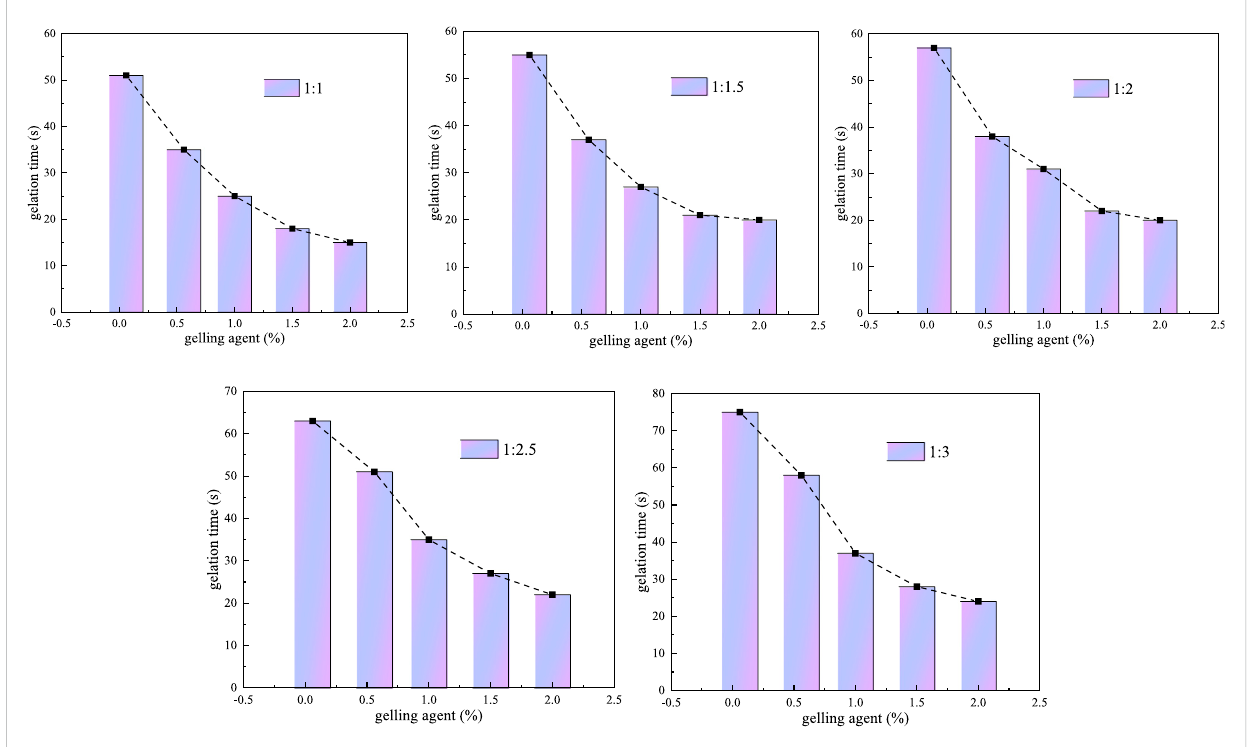
FIGURE 7 Variation curves of the gelling time with the concentration of the gelling agent under different concentration ratios of fl y ash and